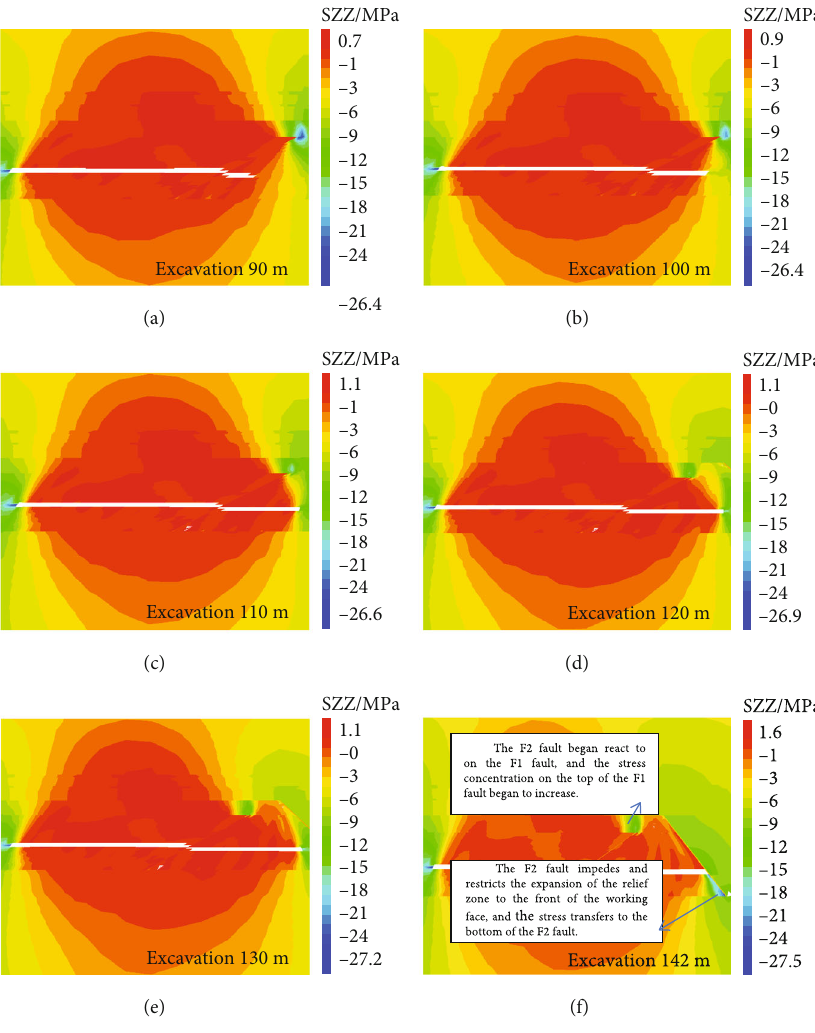
Figure 7: Stress distribution